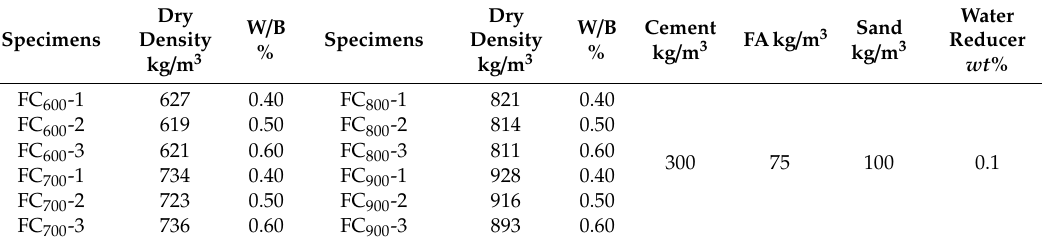
Table 3. Mix ratios of the foam backfill